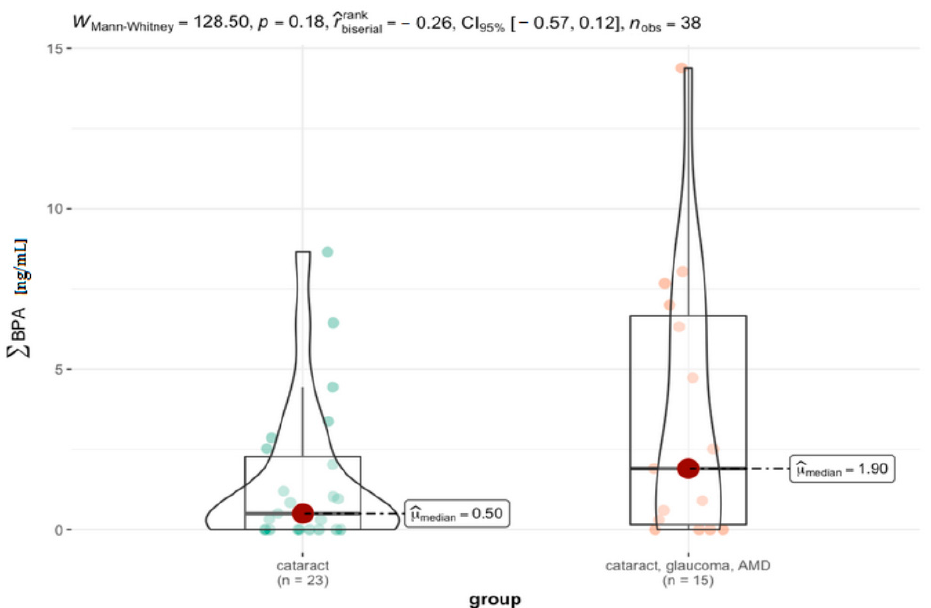
Figure 7. Statistical significance of differences in BPs’ content in AH for cataract and cataract with coexisting ocular pathologies (AMD, glaucoma).